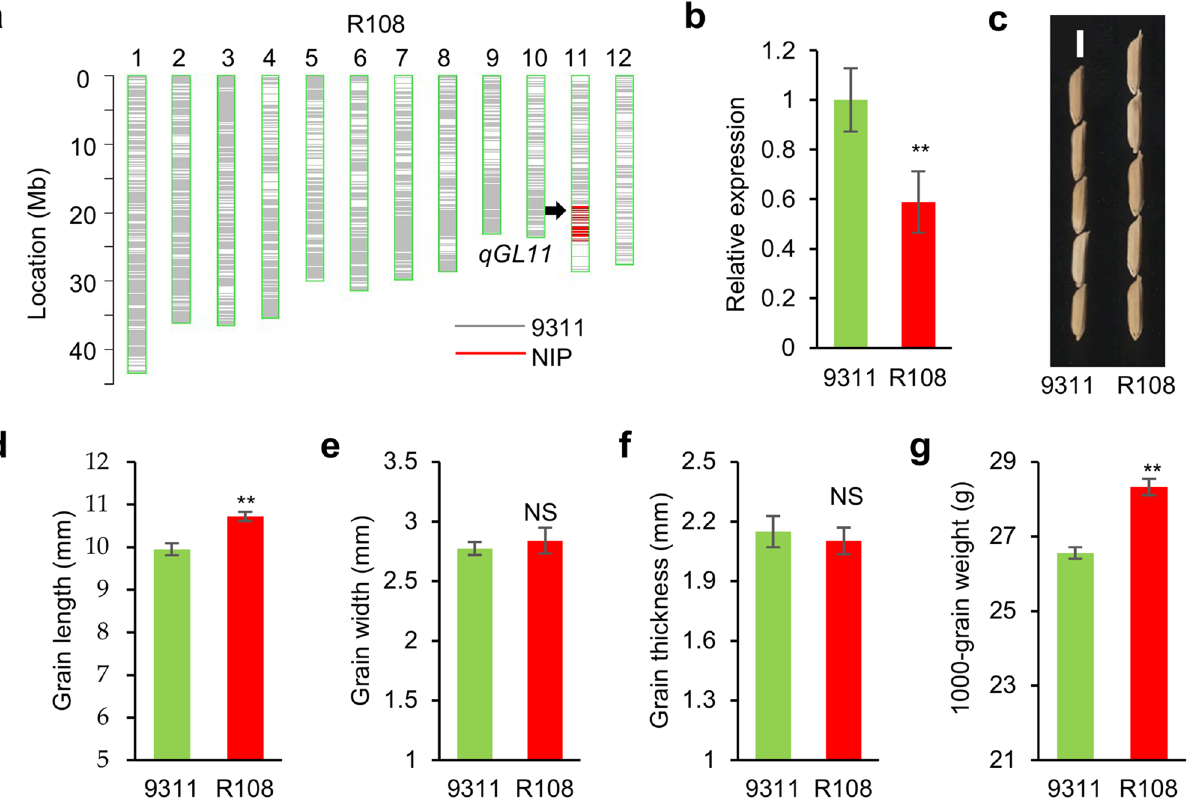
Figure 4. Comparative analysis of NILs containing qGL11 in the background of 9311. ( a ) Graphic representation of the genotype of R108 that carries a single substituted segment encompassing qGL11 . ( b ) Relative expression of OsGH3.13 of 9311 and R108 in the 8-cm panicle. Transcription levels relative to 9311, which was set to 1, are presented as the mean and SE ( n = 3). Ubiquitin is the control gene. ( c – g ) Differences between 9311 and R108 in seed morphology ( c ), scale = 5 mm, grain length ( d ), grain width ( e ), grain thickness ( f ) and thousand-grain weight ( g ). ( d – g ) Data are given as the mean and SE ( n = 6). ** and NS indicate statistically significant differences by Student’s t -test at P < 0.01 and no significance,